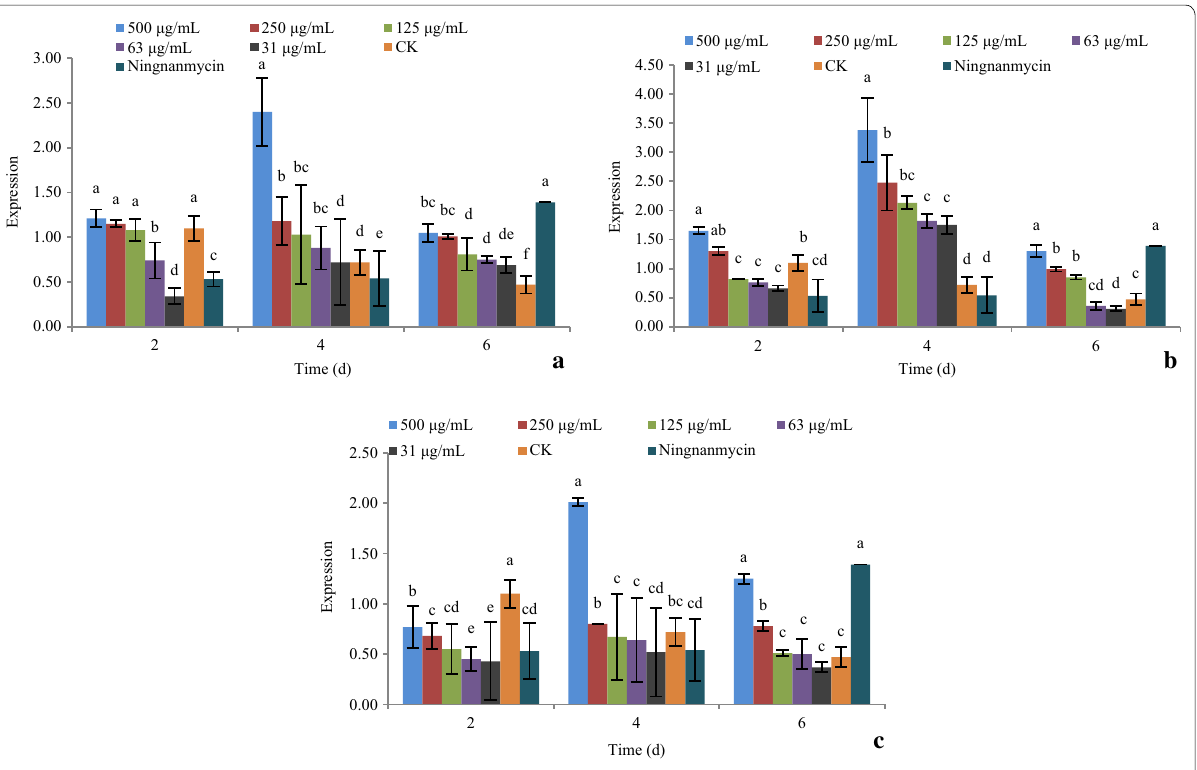
Fig. 5 The effect of active compounds 1 , 5 , and 9 on the expression of gene PSii . a Compound 1 ; b Compound 5 ; c Compound